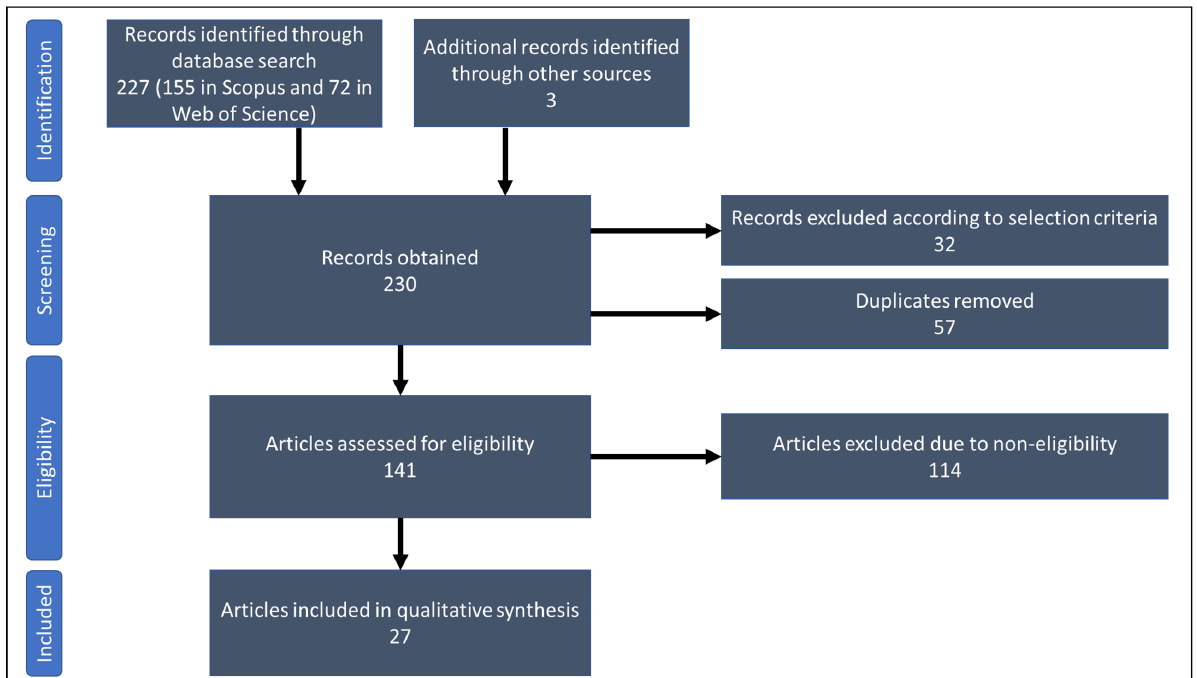
Figure 4. Search process for computable general equilibrium models dealing with aviation, de- signed in accordance with the Preferred Reporting Items for Systematic Reviews and Meta-Analyses (PRISMA) statement (adapted from Moher et al.